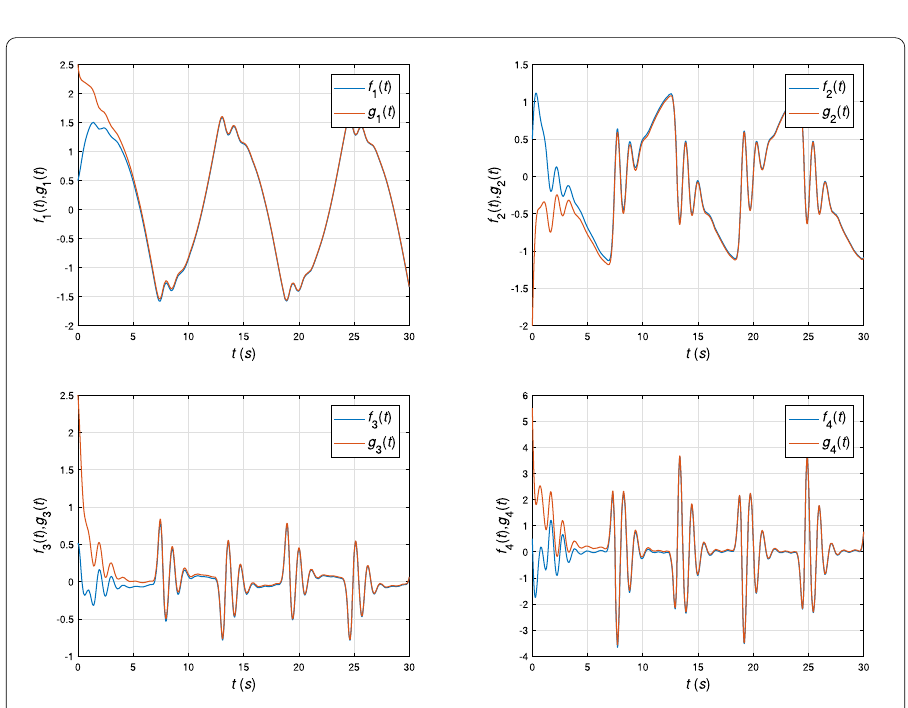
Figure 14 The state trajectories of the synchronized systems (19) and (20) for q =